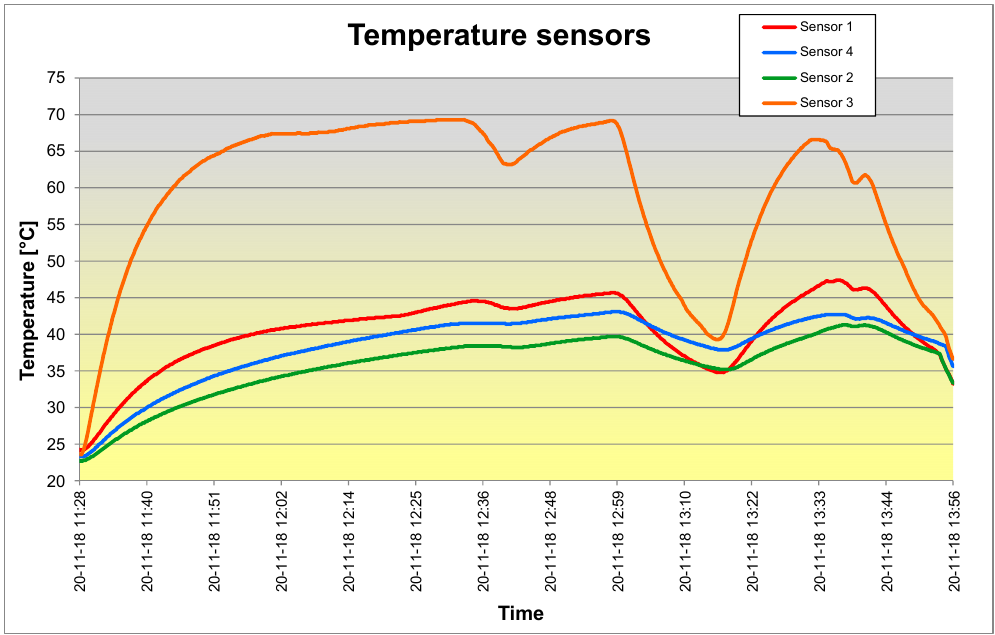
Figure 15. Graph of temperature values on the time axis obtained from the measurements.